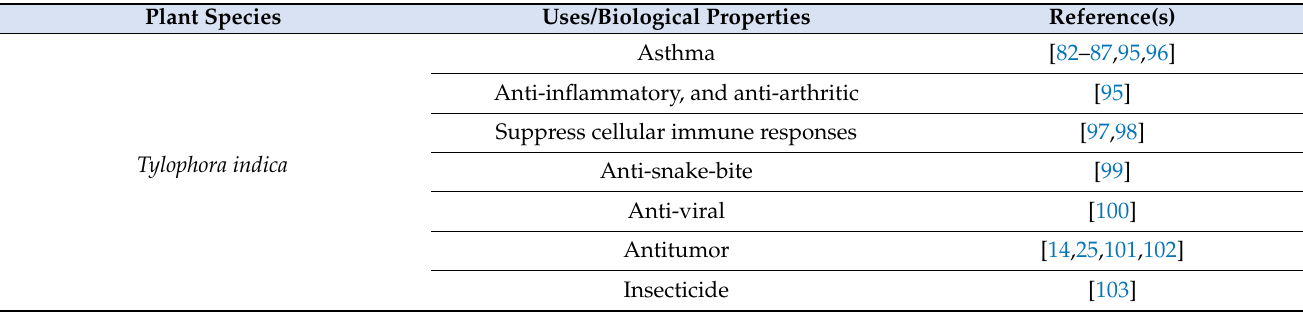
Table 5. Uses and biological activities of various Tylophora species. Plant Species Uses/Biological Properties